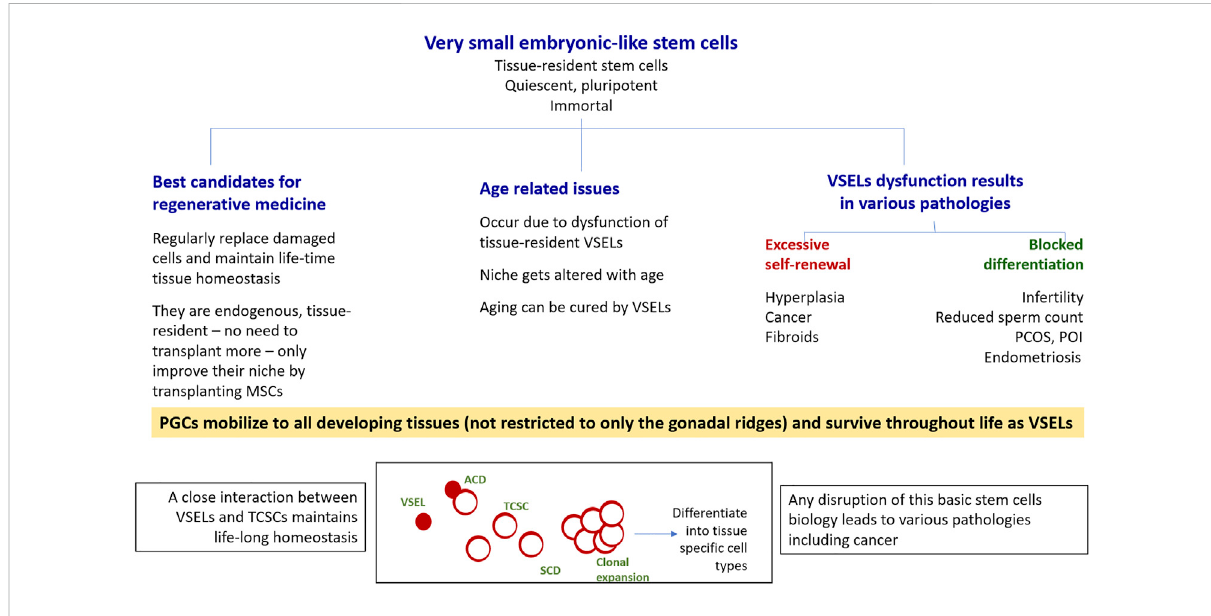
FIGURE 2 VSELshavethepotentialtowinthewarforhumanhealthonthreemajorfronts.Asshown,VSELshavetheabilitytoregenerateadulttissueswithnoneofthe associated problems currently facing human embryonic and induced pluripotent stem cells, including ethical concerns as well as genomic instability, tumorigenicity,immunogenicity,andheterogeneity.Age-relateddisordersoccurduetoVSELdysfunction.Variouspathologies,includingcancer,occurduetothe dysfunctionofthestem/progenitorcellcompartmentinadulttissues,asshowninthebottompanel.Excessiveself-renewalofVSELsresultsincancer,and theblockingofstem/progenitorcellsdifferentiation(todifferentextents)givesrisetoawidespectrumofpathologies.Thiswas fi rstrevealedthroughstudyingthe effects of neonatal exposure to endocrine disruption on mouse reproductive tissues, but similar mechanisms could exist in other organs as well. Morefocused research on various aspects of VSELs is needed. VSELs, very small embryonic-like stem cells; PGCs, primordial germ cells; TCSCs, tissue-committed stem cells (progenitors); ACD, asymmetrical cell division; SCD, symmetrical cell